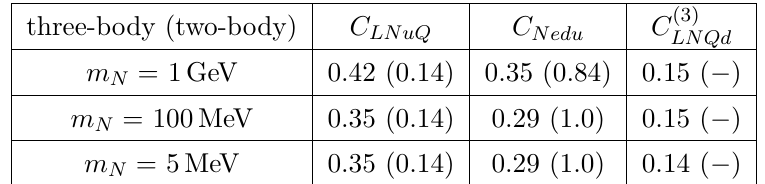
Figure 5 . γ ‘‘ distributions with P ¯ = 1 in the ¯ N rest frame. Left panel: the distributions for N three vector ¯ N decay operators: O LN (black), O Ne (red), O Ne + O LN (purple) for DF (dotted lines) and MF (dashed lines) decays. The DF and MF distributions are identical. Middle panel: the distributions for the scalar operator O LNLe for DF (dotted lines) and MF (dashed lines) decays. Right panel: the distributions for DF and vector operator O LN (dotted red), and MF and scalar operator O LNLe (dashed green), overlap completely.